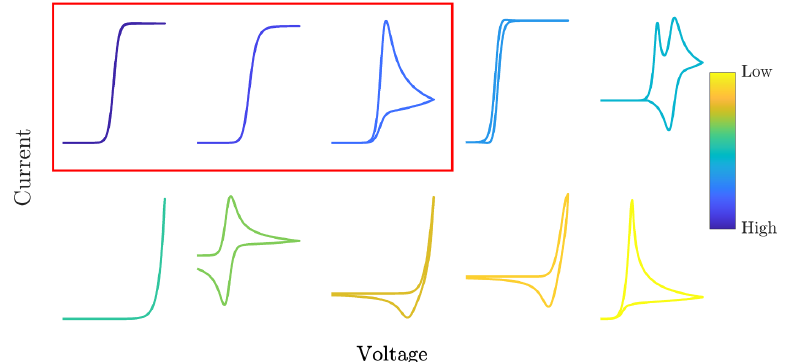
Figure 5. Representative CV curves from the dataset ordered and color coded using the similarity score. CV curves in the red box will be labeled as targets by the similarity score based oracle described in this